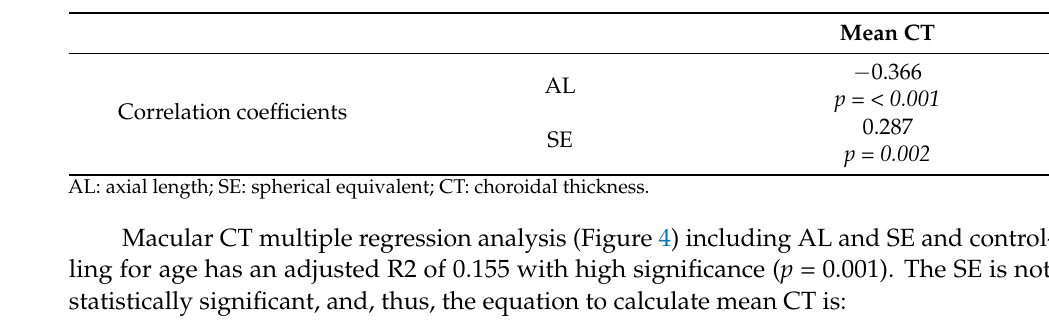
Mean CT 0.274 Mean CT 0.274 p = 0.305 0.018 Mean CT − 0.366 Mean CT p = < 0.001 − 0.366 0.287 p = < 0.001 0.287 p = 0.002 p = 0.002